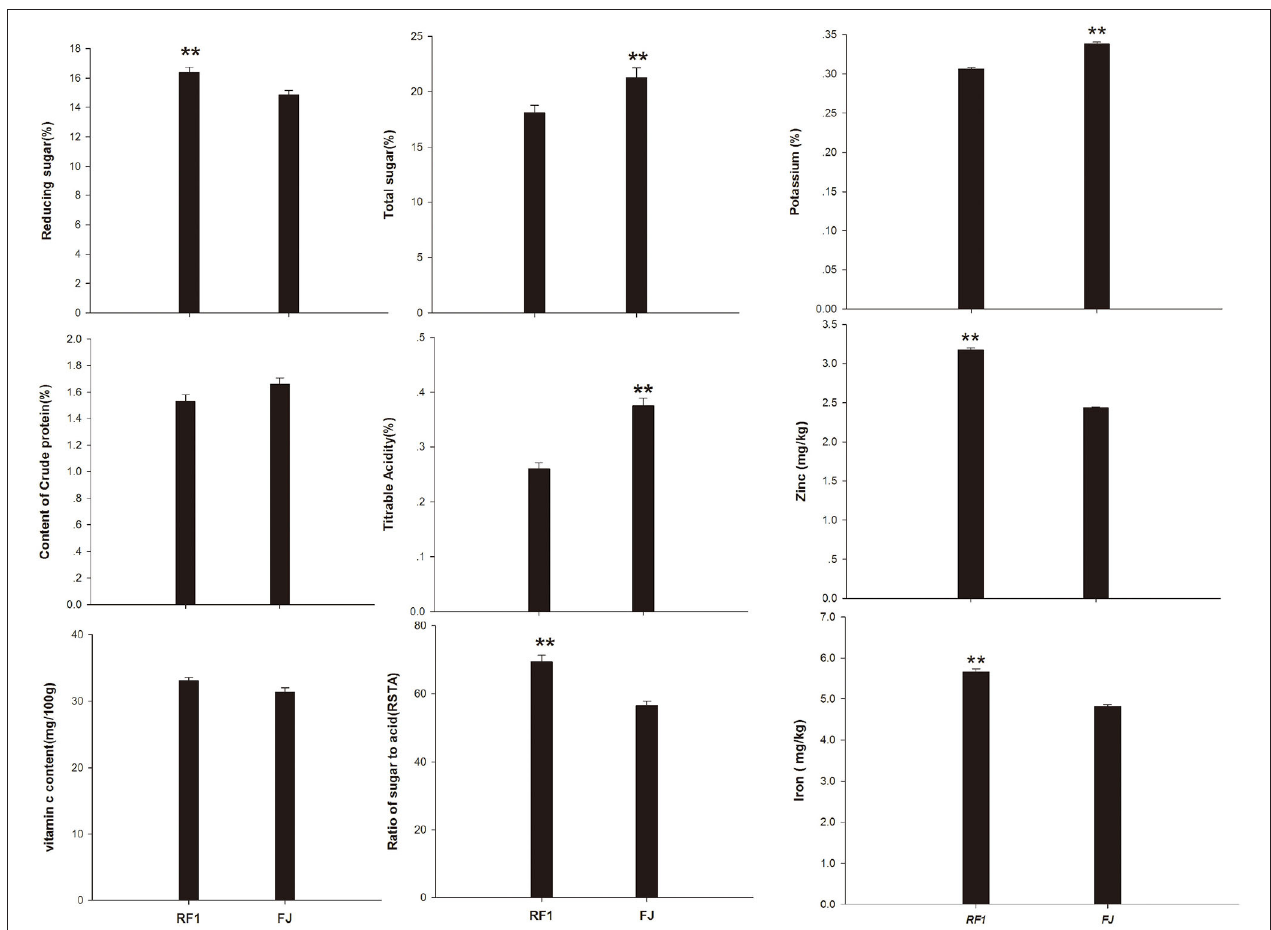
FIGURE 3 | Comparison of fruits nutrients between RF1 and FJ during fruit ripening stages. Data are the mean ± SD ( n = 10); One-way ANOVA was used to assess statistical significance (** p < 0.01).